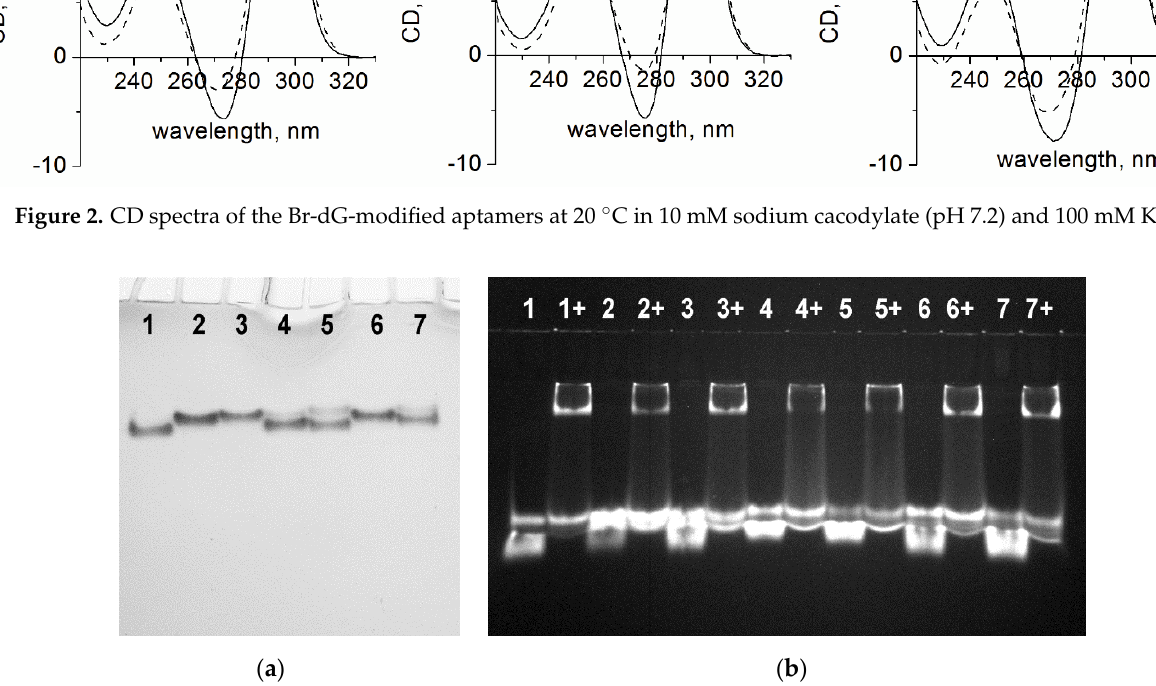
Figure 3. ( a ) Native polyacrylamide gel electrophoresis of the Br-dG-modified aptamers in the presence of 10 mM KCl at 20 °C: (1) TBA-ppg, (2) 2Br(2/4), (3) 4Br(2/4), (4) 2Br(1/3), (5) 4Br(1/3), (6) 2Br(1/2), (7) 4Br(1/2). ( b ) Native gel-electrophoresis image of the labeled 2Br and 4Br aptamers alone and in the presence of 2.4 equivalent thrombin (12% polyacrylamide gel, 20 °C, 10 mM KCl): (1) TBA-ppg-Cy5, (2) 2Br(2/4)-Cy5, (3) 4Br(2/4)-Cy5, (4) 2Br(1/3)-Cy5, (5) 4Br(1/3)-Cy5, (6) 2Br(1/2)-Cy5, and (7) 4Br(1/2)-Cy5. Symbol (+) indicates added thrombin.